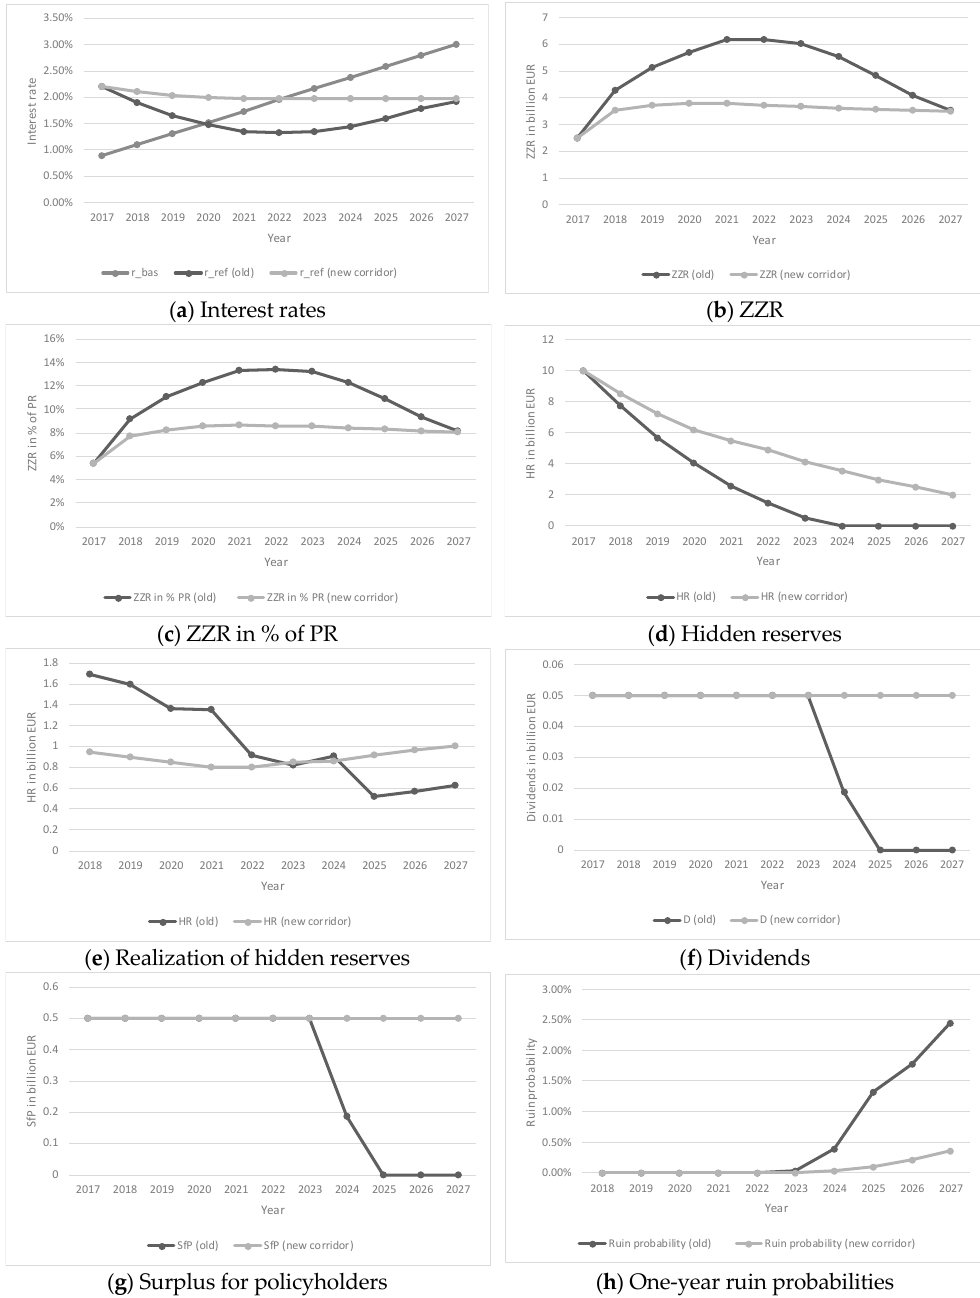
Figure 3. Simulation results in interest rate scenario 3.